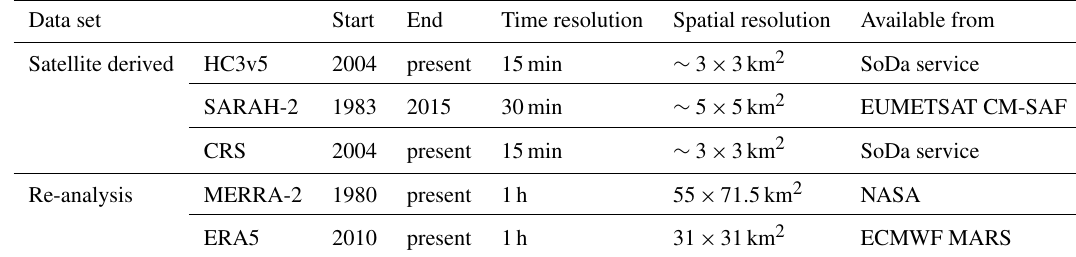
Table 2. Description of the data sets as in March 2018. Data